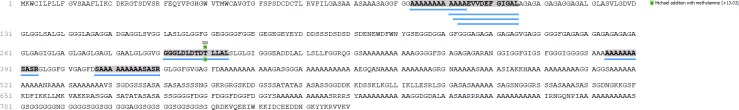
HorC - Hic74 coverage.